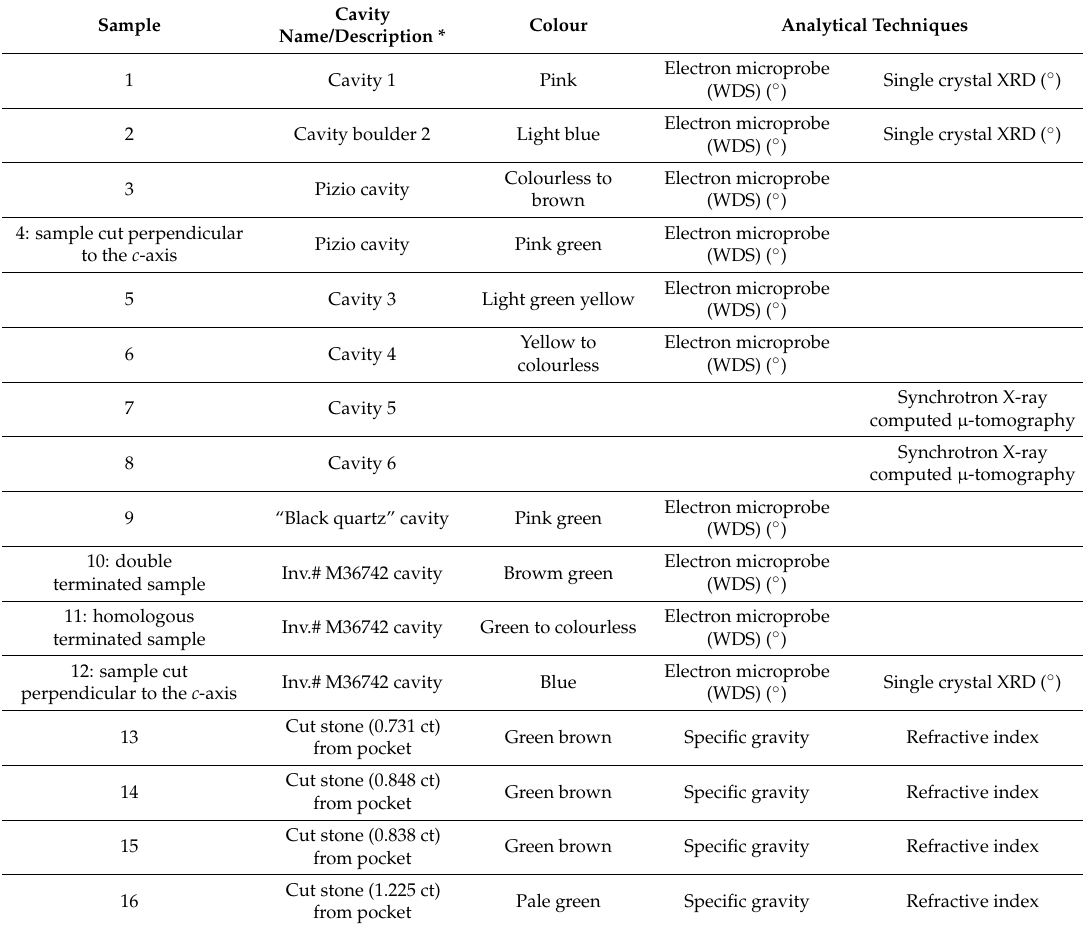
Table 1. Description of the studied